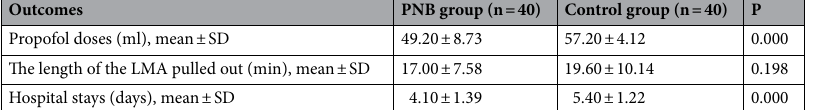
Outcomes PNB group (n = 40) Control group (n = 40) P Propofol doses (ml), mean ± SD